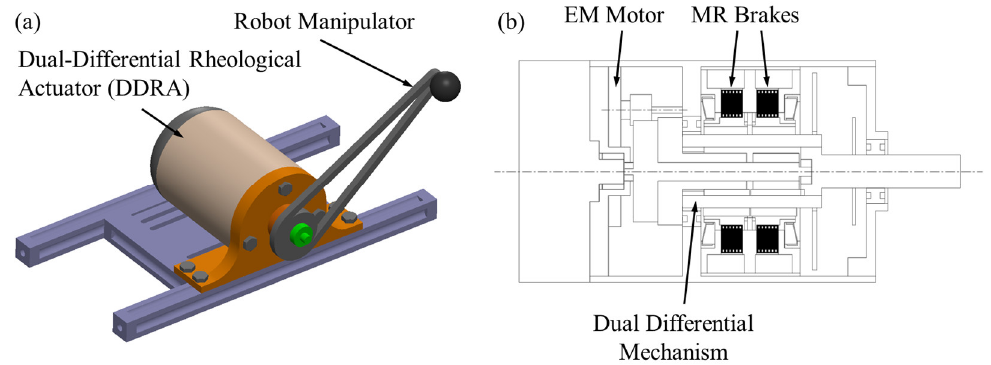
Figure 4. Robot arm featuring dual-differential MR actuator; ( a ) configuration ( b ) section view of DDRA [26].